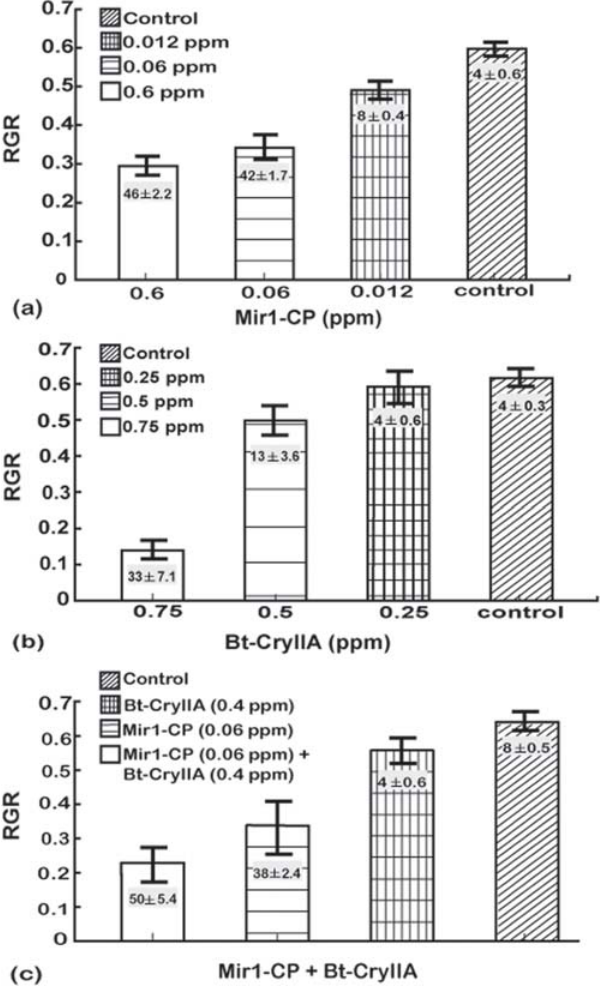
Figure 3. Dose response analysis for fall armyworm larvae fed (a) Mir1-CP, (b) Bt-CryIIA, and (c) sub-lethal doses of Bt-CryIIA and Mir1-CP. The y-axis is the relative growth rate (RGR measured as D mg/(mg avg d) and vertical bars indicate one standard deviation. The least significant difference (LSD) at the 0.05 confidence level for the RGR values were as follows: Mir1-CP – 0.14, Bt-CryIIA – 0.37, sub-lethal doses of Bt-CryIIA and Mir1-CP, combined – 0.46. Numbers (mean 6 SD) in the histogram bars are the average percentage mortality for each treatment. The least significant difference (LSD) at the 0.05 confidence level for mortality were as follows: Mir1-CP – 6.71, Bt-CryIIA – 8.42, sub- lethal doses of Bt-CryIIA and Mir1-CP, combined – 10.01. Results are based on four independent bioassays. Concentrations are given as parts per million (ppm).